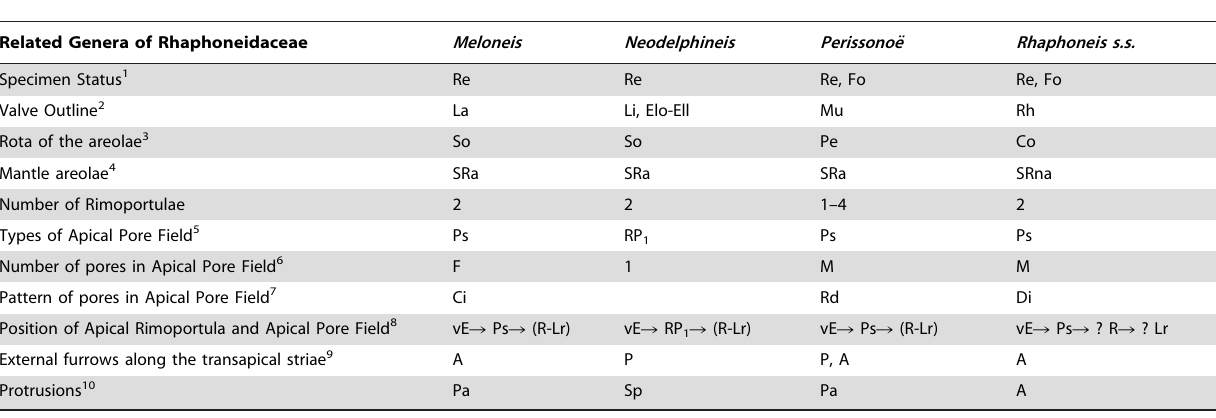
Table 1. Valve morphology - according to the available literature and photodocumentation cited in this paper - differentiating Meloneis from the related genera of the family Rhaphoneidaceae (for the genus Rhaphoneis s.s. characters of the type species Rhaphoneis amphiceros were considered).